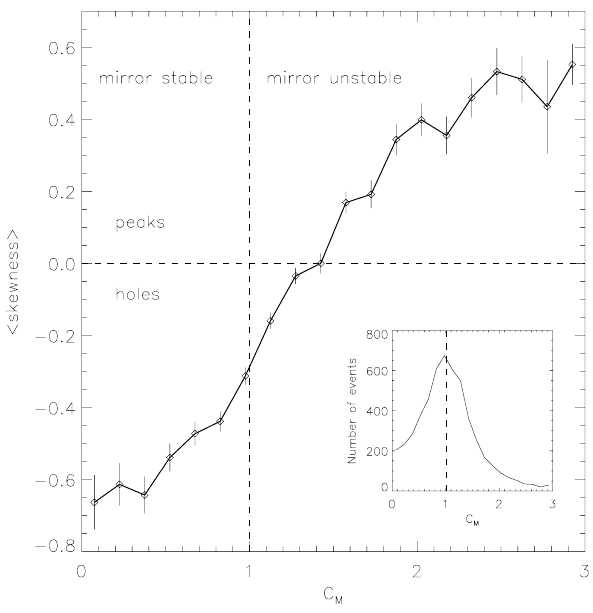
Fig. 5. Average skewness as a function of the mirror parameter C M . The vertical dashed line delineates the mirror threshold. The hor- izontal dashed line delineates the region of predominance of holes (below) from the one of peaks (above). The error bars are pro- √ N where σ is the standard deviation and N is the portional to σ/ number of mirror events in each 1C M = 0 . 15 bin ( N min = 20 and N max = 675). The insert shows the distribution of mirror events as a function of C M : the peak is observed for marginally stable condi- tions with respect to the mirror instability ( C M ’